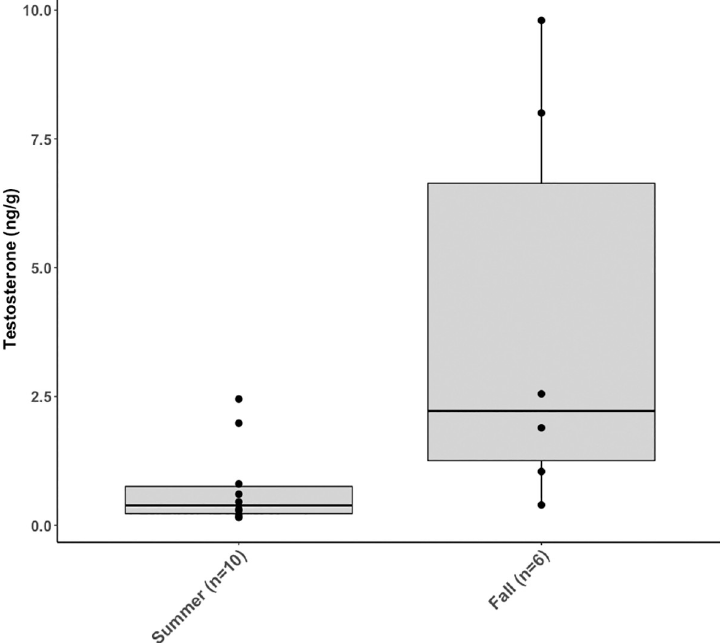
Fig 3. Mean testosterone concentrations (ng/g) were significantly higher in adult males sampled during the fall than during the summer ( P < 0.05). Boxplots denote median (thick line), upper (75%) and lower (25%) quartile (boxes) and largest and smallest value within 1.5 times interquartile range below 25% and above 75% (whiskers). Outside values are shown as filled